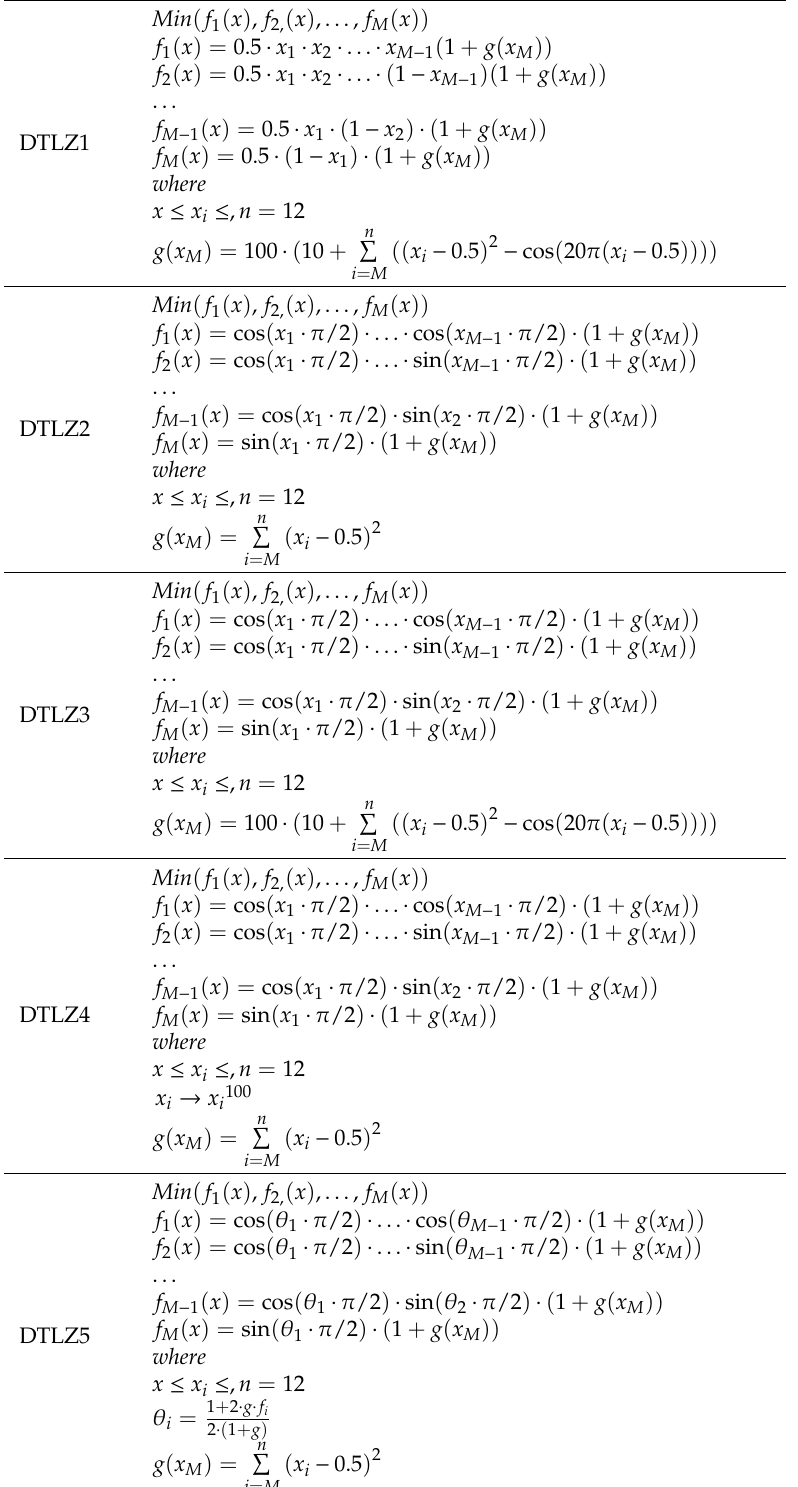
Table A1. DTLZ test functions used for testing IMGAMO algorithm (where n is number of variables and M is number of